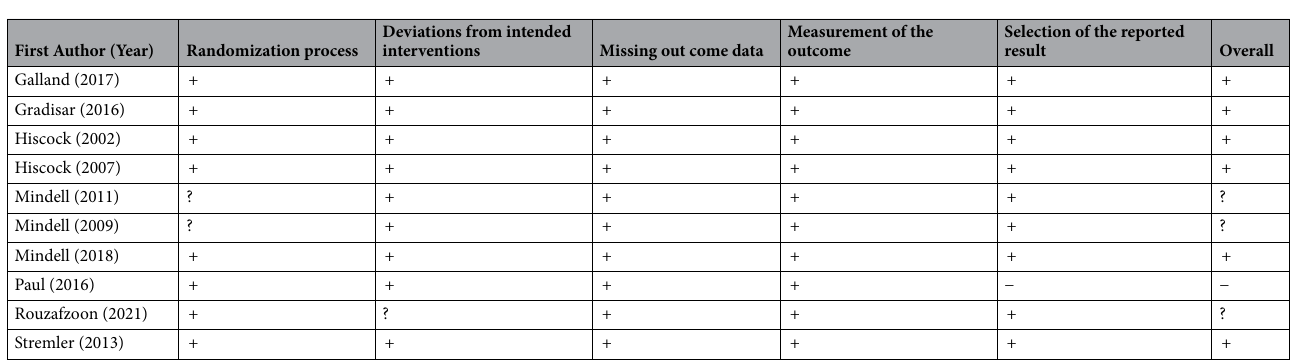
Table 2. Risk of bias summary: researcher’s opinions bout each risk of bias item for all included studies. + = Low risk, ? = Some concerns, − = High